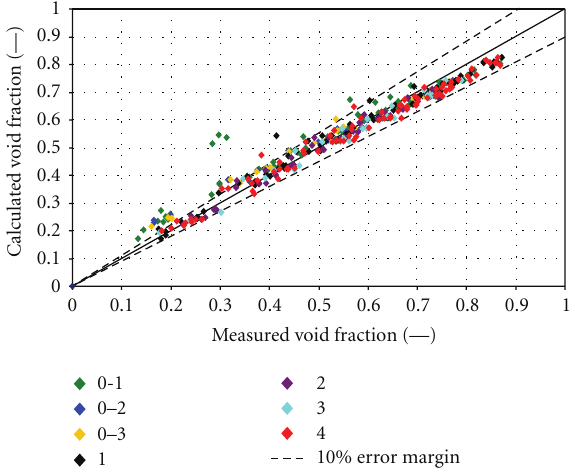
Figure 7: Comparison of predicted and measured void fraction results at 3.758